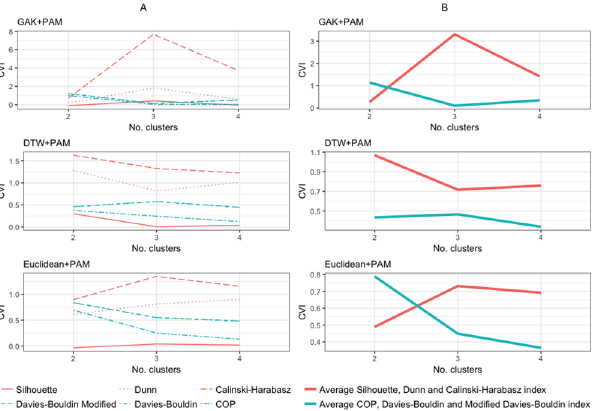
Fig 1. Farm I CVI plots. Cluster validity index plots for the most stable algorithms applied to the time-series data for Farm I in 2012-2013. (A) individual CVI plots; (B) average values for each group of CVIs.